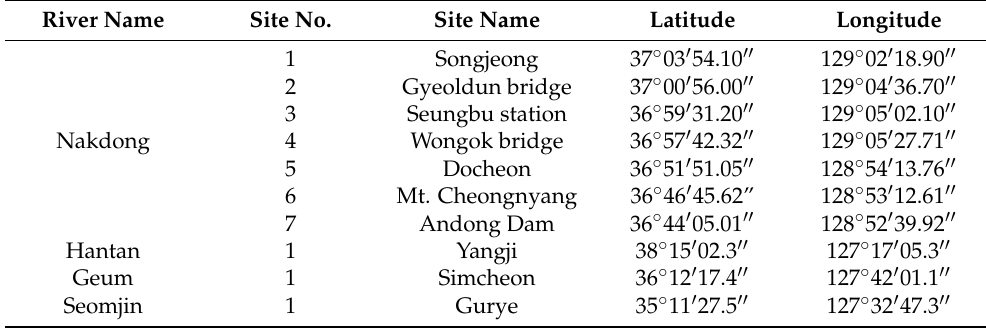
Table 2. Geographical position of the reaches in which the riparian vegetation was investigated in four rivers selected for